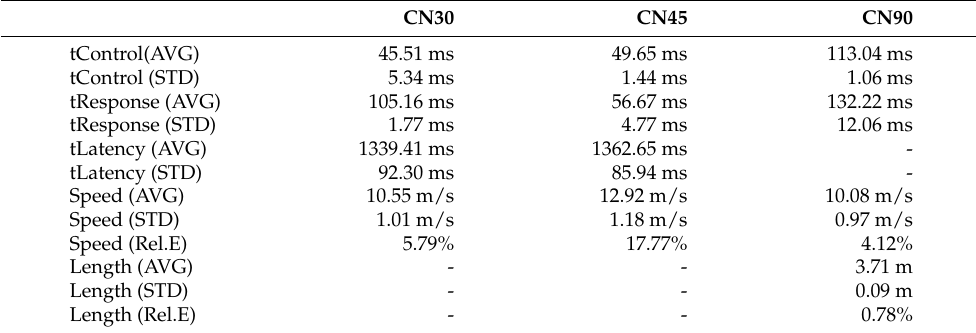
Table 3. Results were obtained from the three CNs processing data and sharing the information obtained. The third module (CN90) uses the speeds calculated by the modules CN30 and CN45 to calculate the vehicle length and the vehicle